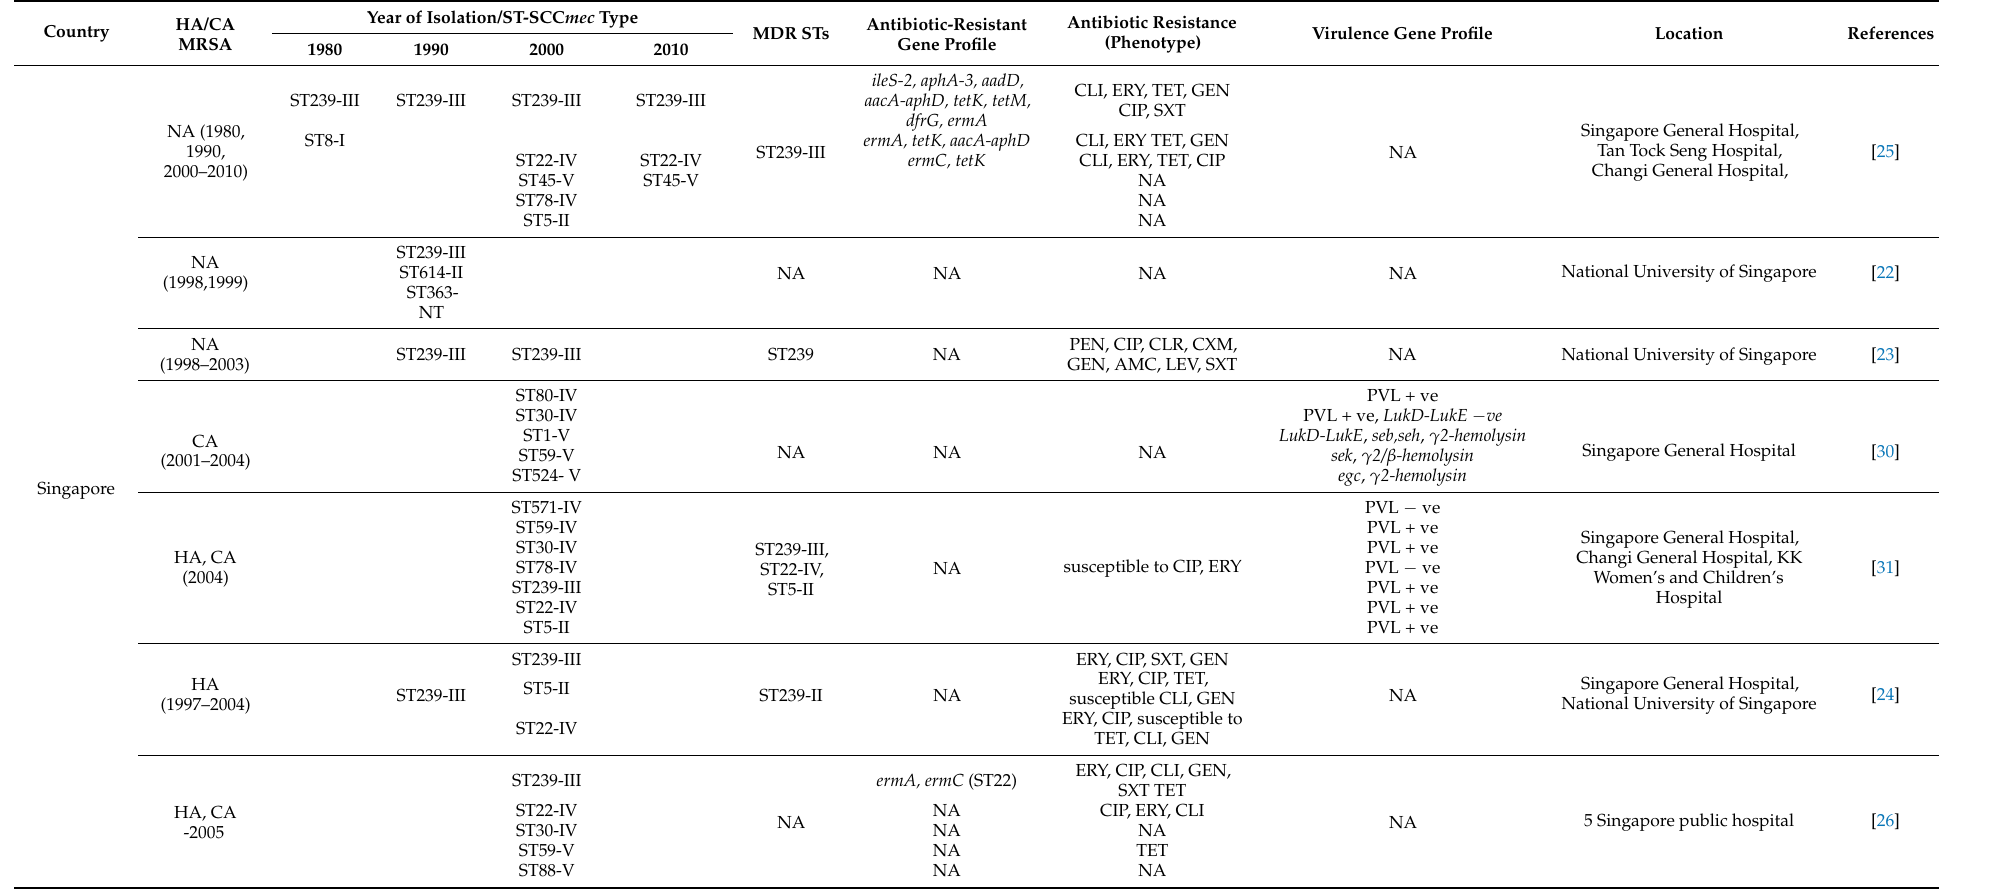
Table 1. The distribution of MRSA genotypes from 1980 to 2010 in Southeast Asian